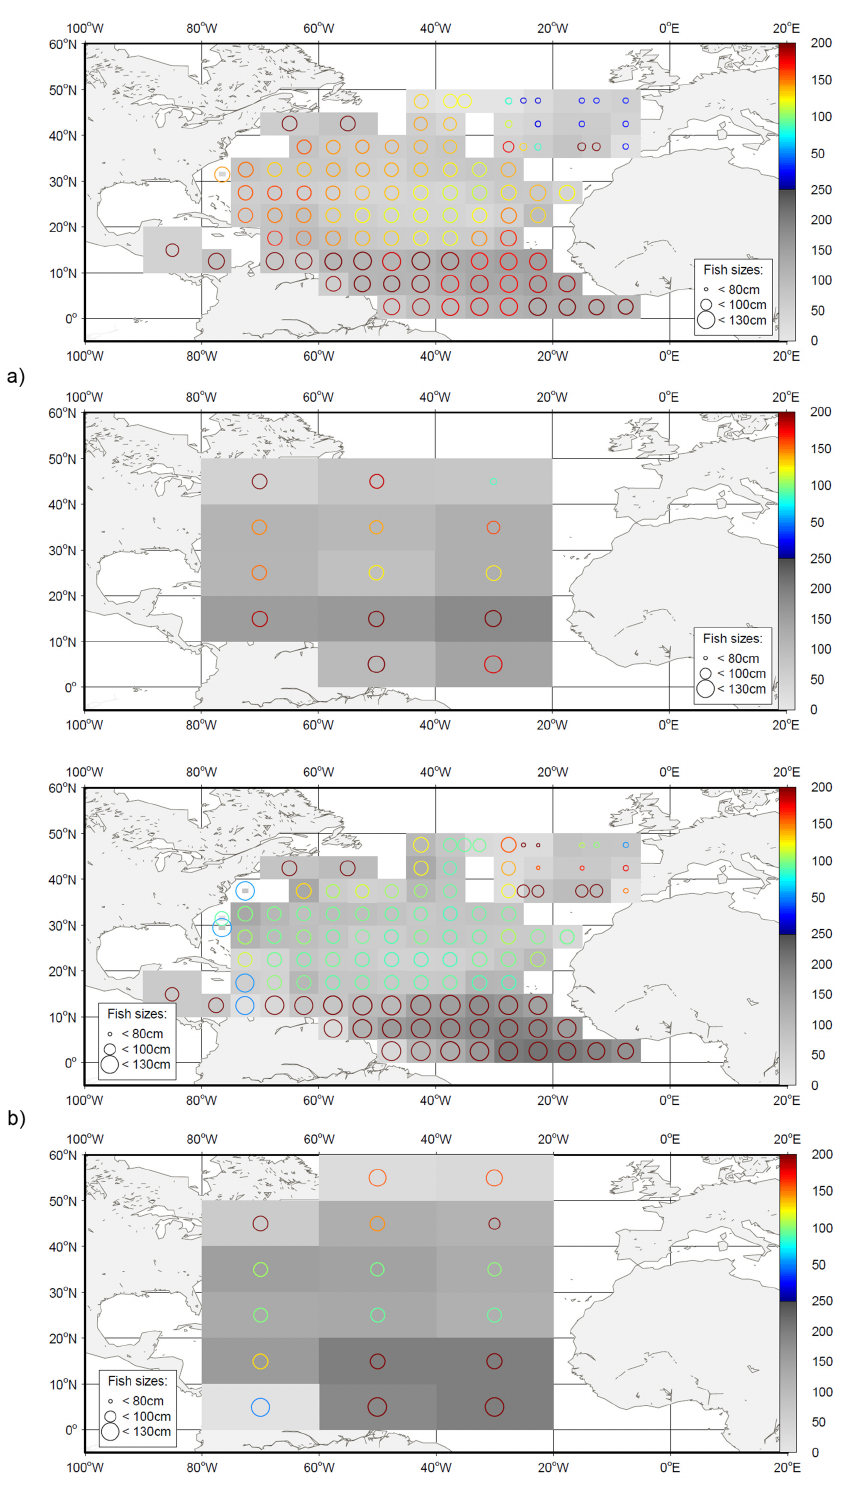
Figure 4. Length frequency data before (a) and after (b) January 1987. The data samples are aggregated at different spatial resolutions illustrated by rectangles with grey shading proportional to the number of samples (black and white color bar from 0 to 200 samples). In the center of each region, a circle gives the predicted mean size of fish (the larger the circle, the larger the mean size of fish in the catches) and the variance associated with this mean (color bar). Data are presented for high (top) and medium (bottom) resolution. The low-resolution data (three geographical boxes: 90 ◦ W–10 ◦ E; 30–6 ◦ N, 80 ◦ W–0 ◦ ; 60–30 ◦ N, 60 ◦ W–20 ◦ E; 6 ◦ N–30 ◦ S) are not shown.